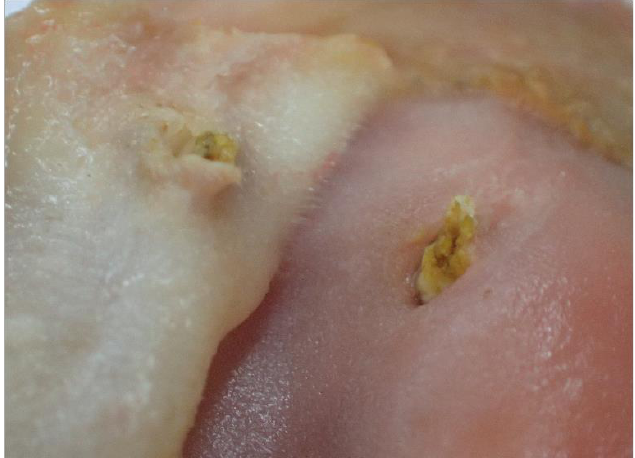
Figure 6. ( a ) Granulomatous and pyogranulomatous serositis of the gizzard. ( b ) Necrotising gastritis of the gizzard of the same animal.